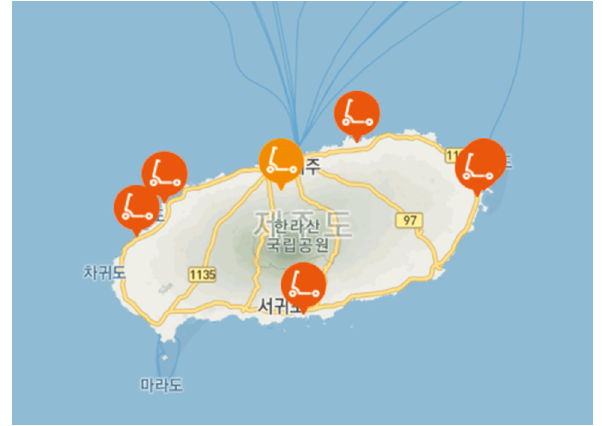
Figure 2: Rental locations of kickboard in Jeju